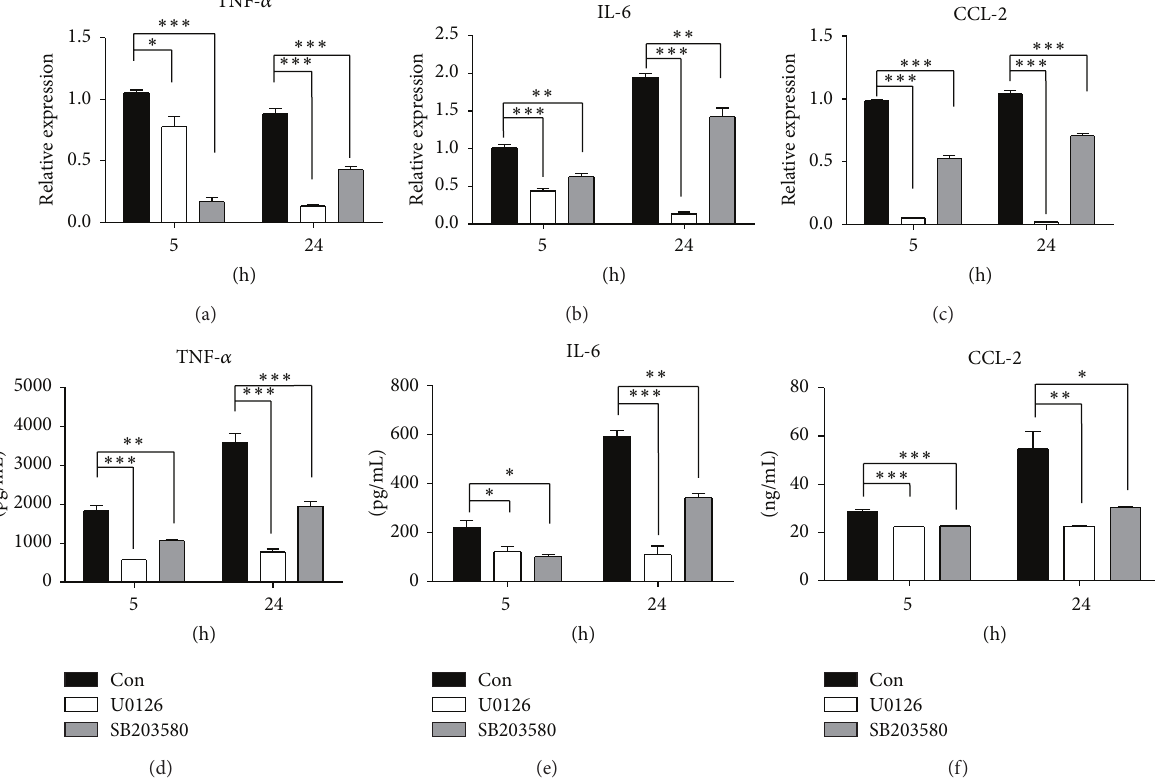
Figure 9: Inflammatory mediators induced by JEV in BV-2 cells treated with ERK and p38MAPK inhibitors. BV-2 cells were infected with JEVatanMOIof1andtreatedwithaninhibitorofERK(10 𝜇 MU0126)orp38MAPK(10 𝜇 MSB302580)after1 hofincubation.Theproduction of TNF- 𝛼 , IL-6, and CCL-2 was measured with qRT-PCR (a–c) or ELISA (d–f) at 5 and 24 hpi. Error bars represent the standard deviation of results from three independent assays ( ∗ 𝑃 < 0.05 ; ∗∗ 𝑃 < 0.01 ; ∗∗∗ 𝑃 < 0.001 ).